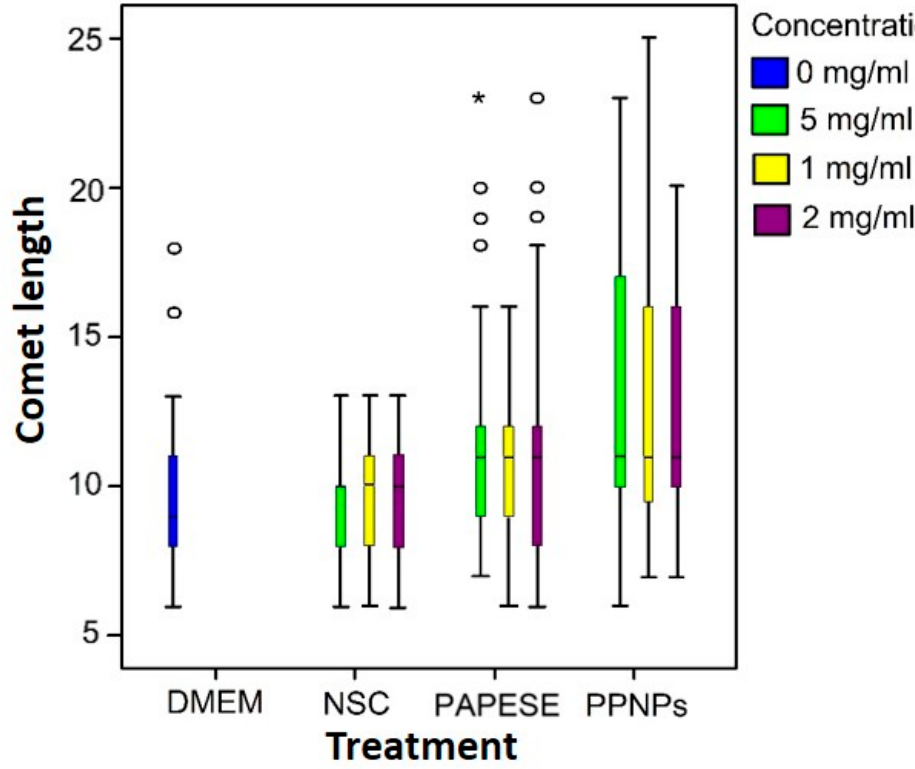
Figure 6. Comet length of human RL14 ventricular cardiomyocytes exposed to PPNPs and their precursors for 24 h. DMEM culture medium was used as a negative control. Outliers circles, and * p < 0.001.